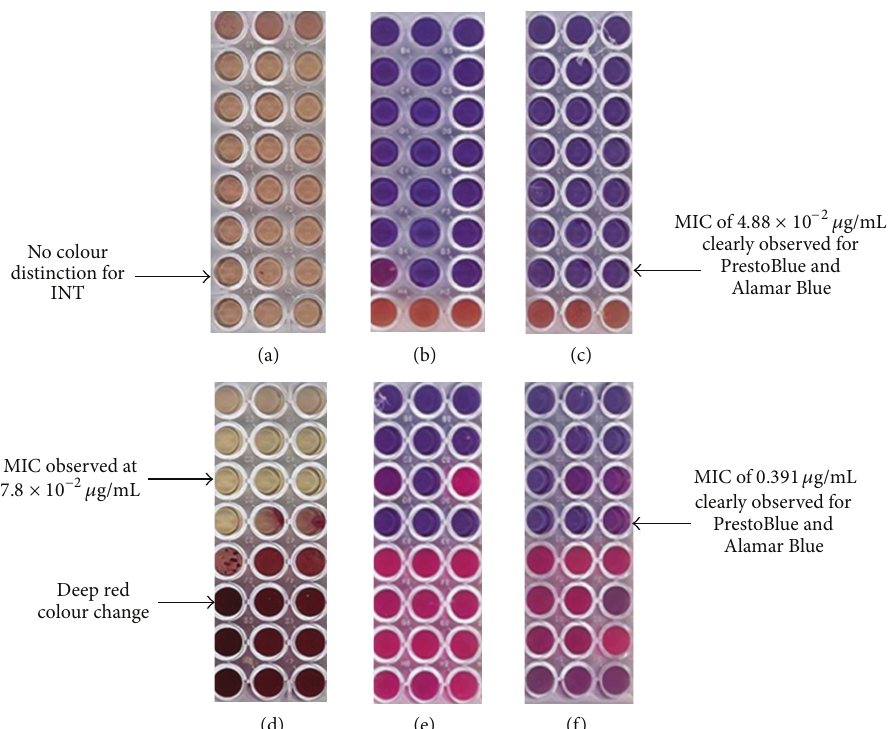
Figure 1: Comparison of different growth indicators on oral microorganisms, (a) INT on S. mutans, (b) PrestoBlue on S. mutans, (c) Alamar Blue on S. mutans, (d) INT on P. intermedia, (e) PrestoBlue on P. intermedia and (f) Alamar Blue on P. intermedia.